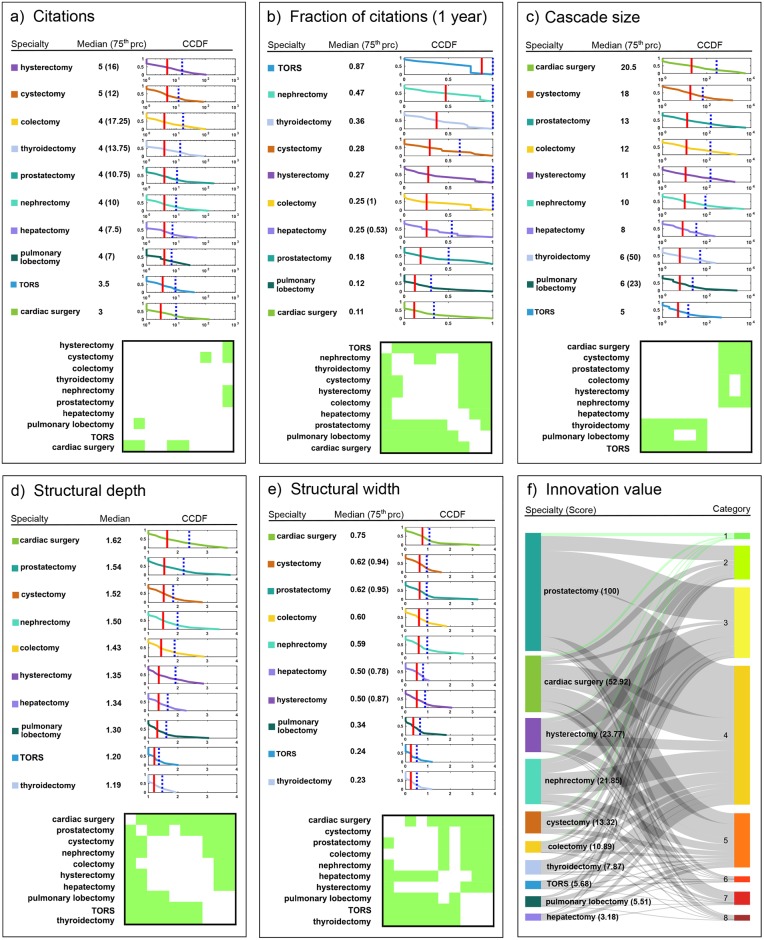
Rankings of surgical specialties.(a) Ranking by citations to seed articles; (b) ranking by fraction of citations to seed articles within one year; (c) ranking by cascade size; (d) ranking by structural depth; (e) ranking by structural width. Rankings were obtained by using the medians (red lines) of the complementary cumulative distribution functions (CCDFs). In case of ties between medians, the 75th percentiles (dotted blue lines) were used. The bottom of each panel shows results from Mann-Whitney U tests (for citations and size) and Kolmogorov-Smirnov tests (for fraction of citations, depth, and width) of independence between pairs of distributions (green color: p<0.05). For clarity, specialties are reported only as labels to the rows of the square matrix, but are equally listed as labels to the columns from left to right. (f) Sankey diagram representing the ranking of surgical specialties in terms of innovation index. Specialties are listed in the left column, with the top-ranked scoring the highest by innovation index. The height of colored bars is proportional to the number of published articles in the corresponding specialty. Levels of evidence are listed in the right column, with the top-ranked being the final implementation stage. The height of colored bars is proportional to the number of published articles at the corresponding level of evidence across all specialties. The width of the lines connecting a given specialty to a given level of evidence is proportional to the number of articles published by the specialty at that level of evidence. Green lines refer to contributions of specialties to the final stage of implementation.